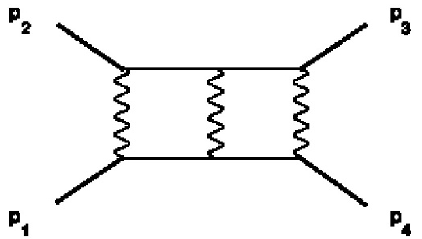
Figure 11. Bhabha | (cid:12)rst planar